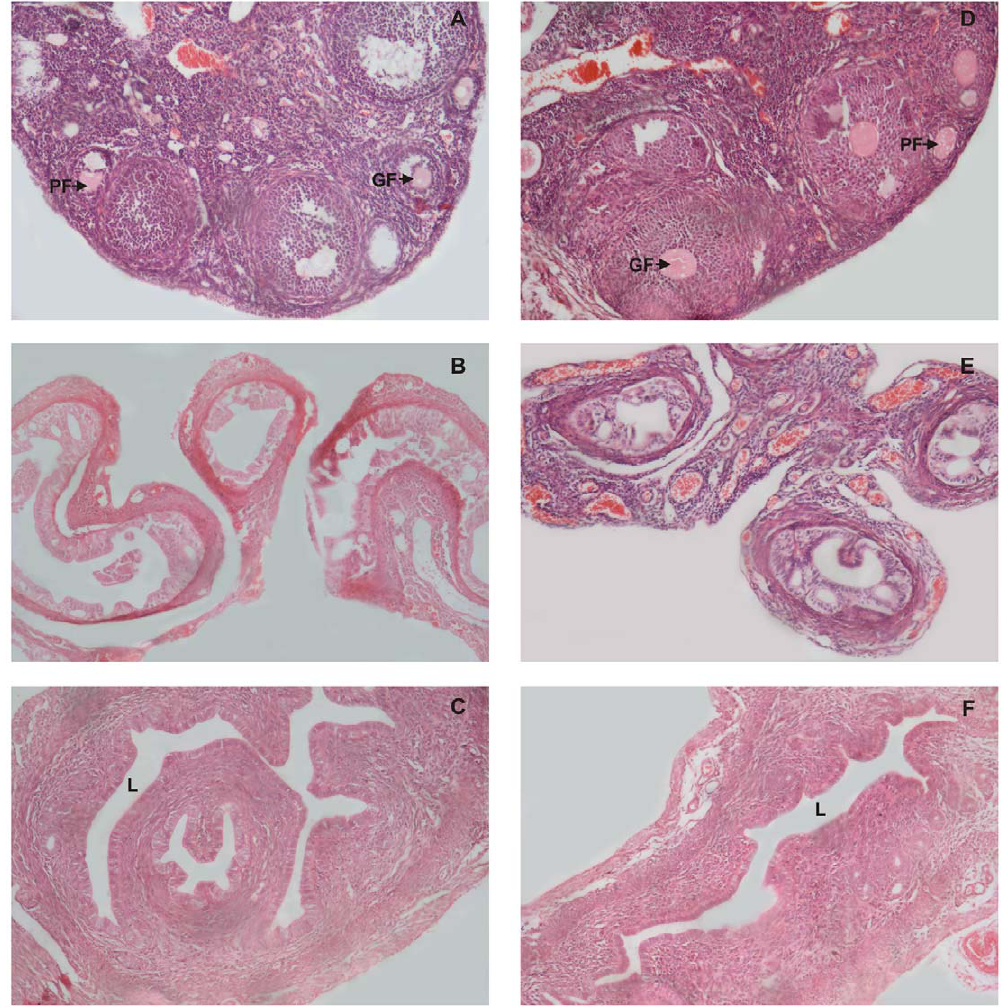
Figure 1. Histological examination of reproductive organs on day 12 after intravaginal administration of PBS (Control) or spermagglutinating strain of S.aureus for 10 consecutive days. Hematoxylin and eosin stained sections and light micrographs of the ovaries, fallopian tubes and uterus of mice, 12 days after inoculation with S. aureus (D–F) compared with control sections (A–C). Ovaries, fallopian tubes and uterus show normal histology in both the groups. Graaffian and primodial follicles are prominently seen in ovaries of both the groups (PF and GF). Original magnification 100X. doi:10.1371/journal.pone.0052325.g001 PLOS ONE | www.plosone.org 2 December 2012 | Volume 7 | Issue 12 |